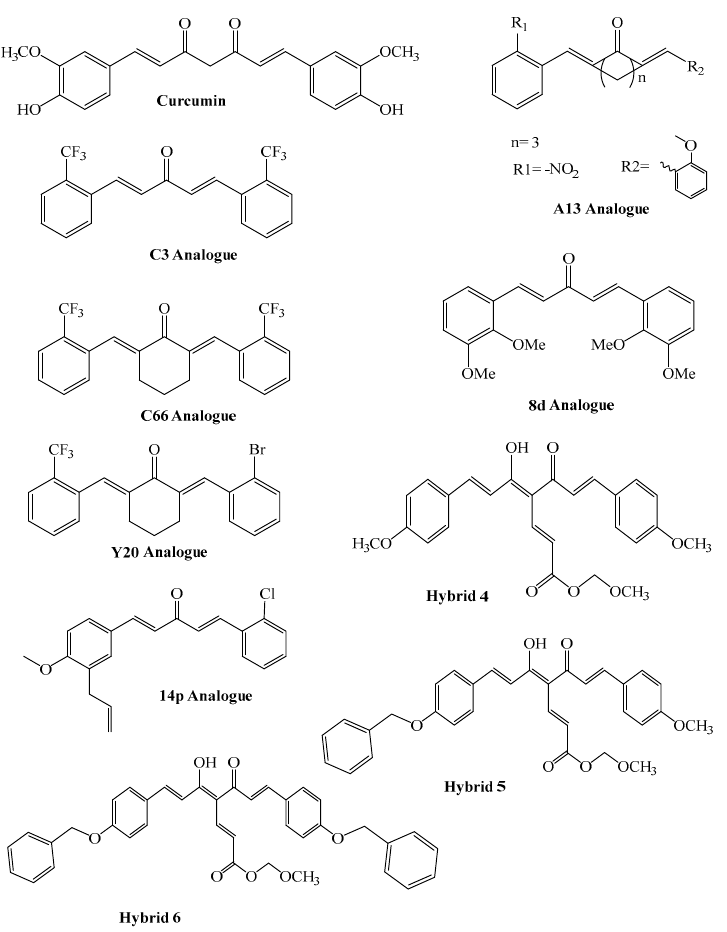
Figure 3. Structures of Curcumin and its different analogues.